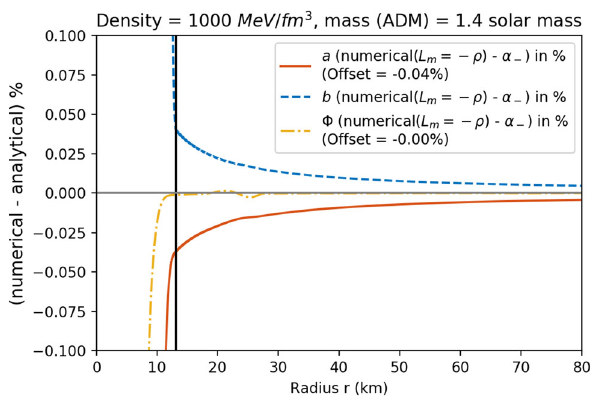
Fig. 2 % difference of the metric components and the scalar field between the analytical solution α − and the numerical solution for = − ρ , for ρ = 1000 MeV / f m 3 . The vertical line indicates the L m 0 radius of the compact object